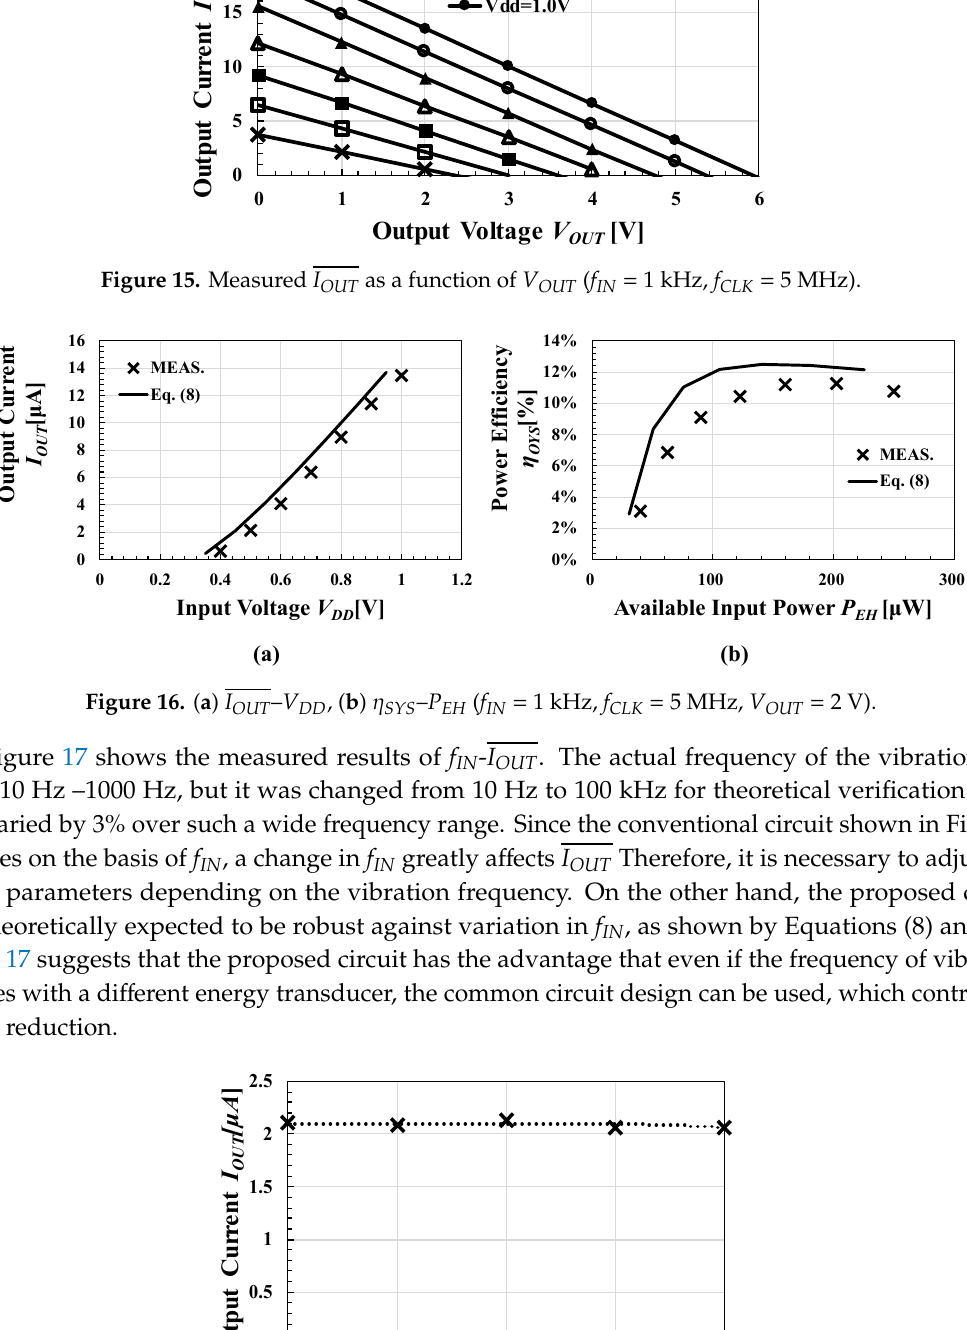
Figure 14. η TOT as a function of f CLK ( V DD = 0.5 V , V OUT = 2 V, f IN = 1 kHz).